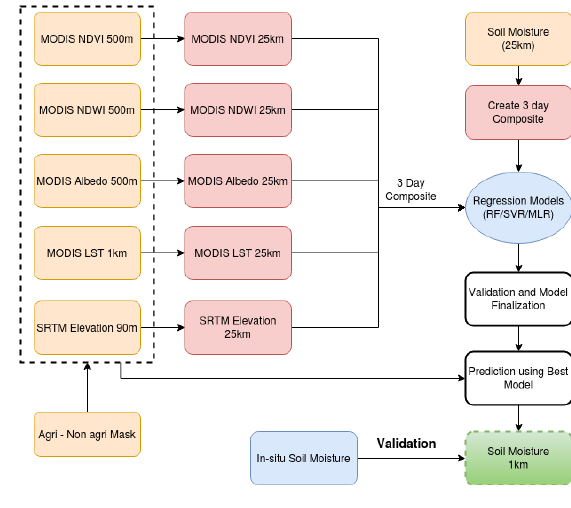
Figure 3. Overall analysis